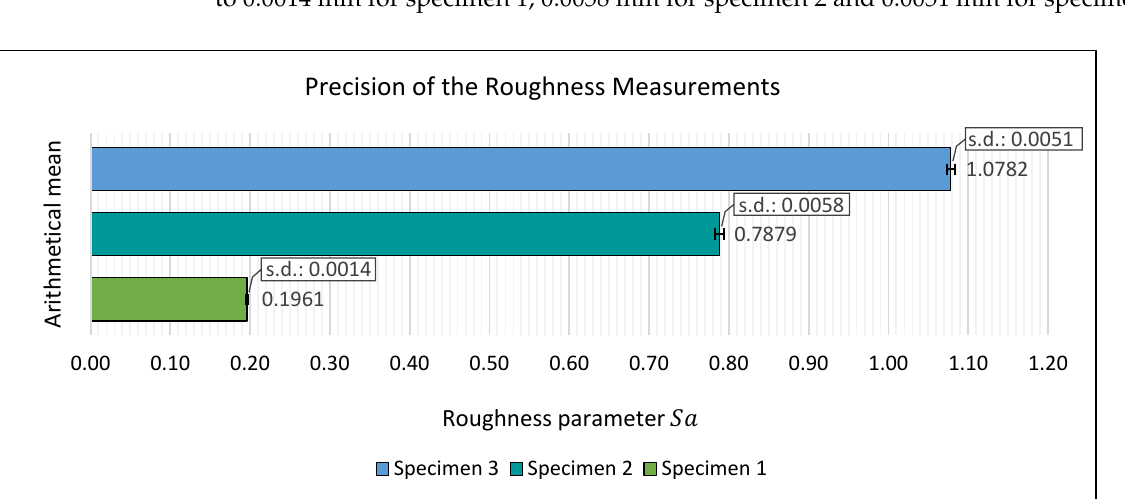
Figure 10. Results for the precision of the roughness measurements.